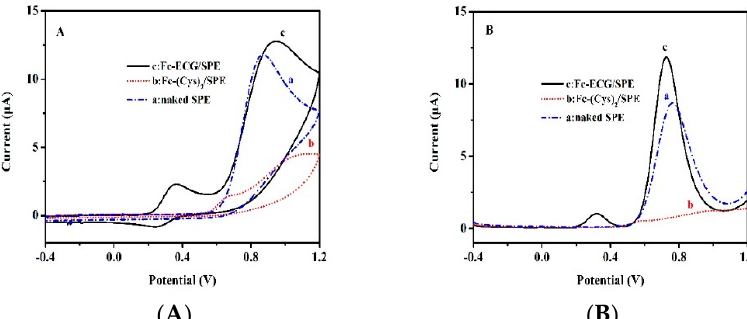
Figure 4. CV( A ) and DPV( B ) curves of different materials modified SPEs for detection of 100 Figure 4. CV ( A ) and DPV ( B ) curves of different materials modified SPEs for detection of 100 µ mol · L − 1 nitrite in 0.1 mol · L − 1 PBS (pH 7.0) (a: naked SPE, b: Fc(Cys) 2 /SPE; c: Fc-ECG/SPE).